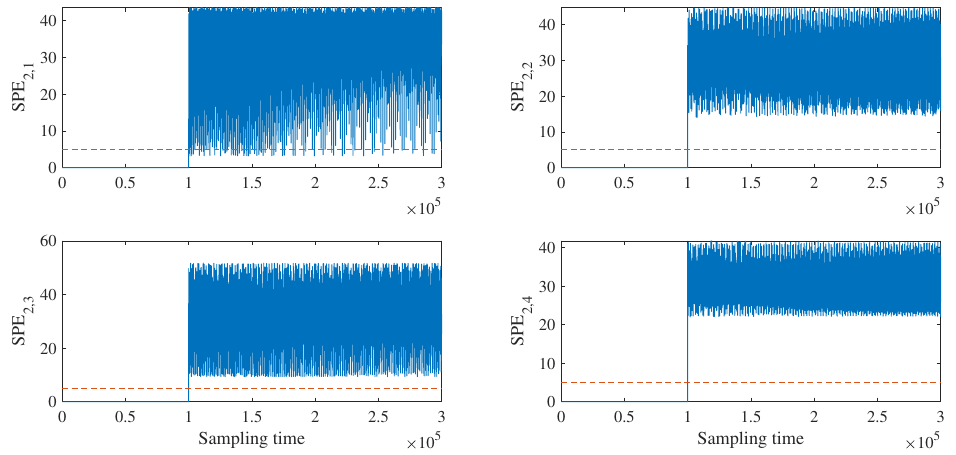
Figure 16. Deep PCA-based fault detection for f 1 with FNR enhancement.